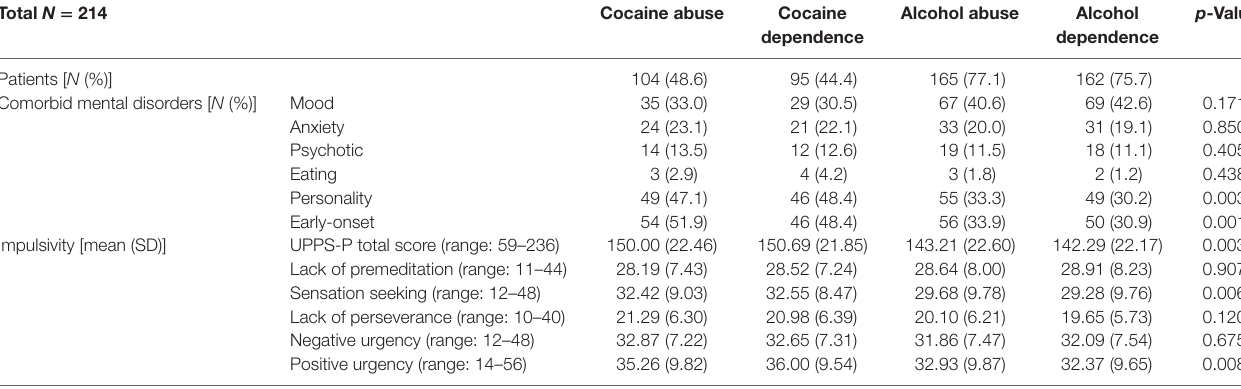
Table 3 | Comorbid mental disorders and impulsivity in addicted patients according to substance use disorders.